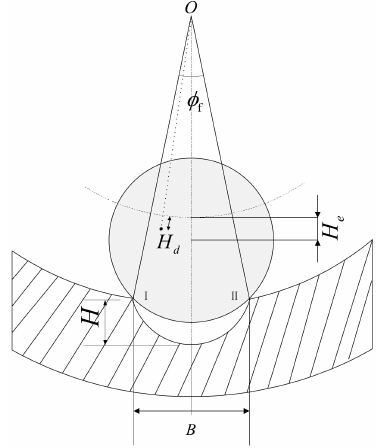
Figure 3. TVDE of the roller.